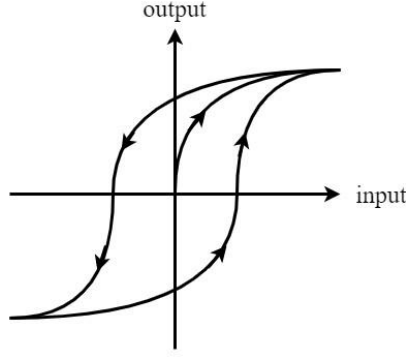
Figure 1. Illustration of the hysteresis loop.